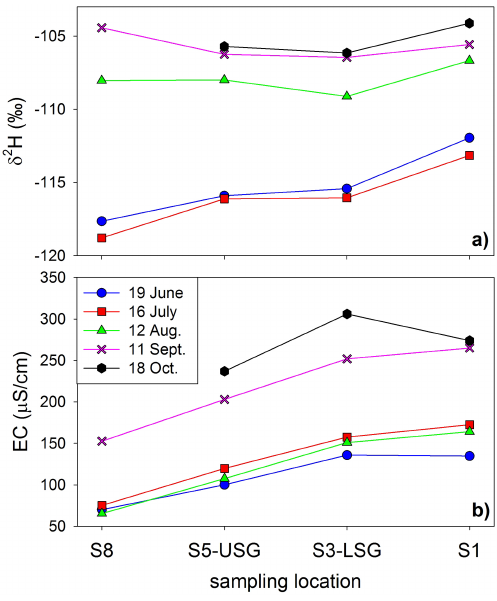
Figure 9. Isotopic composition and EC of stream water measured at selected locations along the Saldur River for different sampling days during the 2013 monitoring year. Sampling started at 15:00LT at S8 and ended approximately at 17:30 at S1. On 18 October it was not possible to sample location S8, sampling started at S5-USG and was carried out between 13:45 and